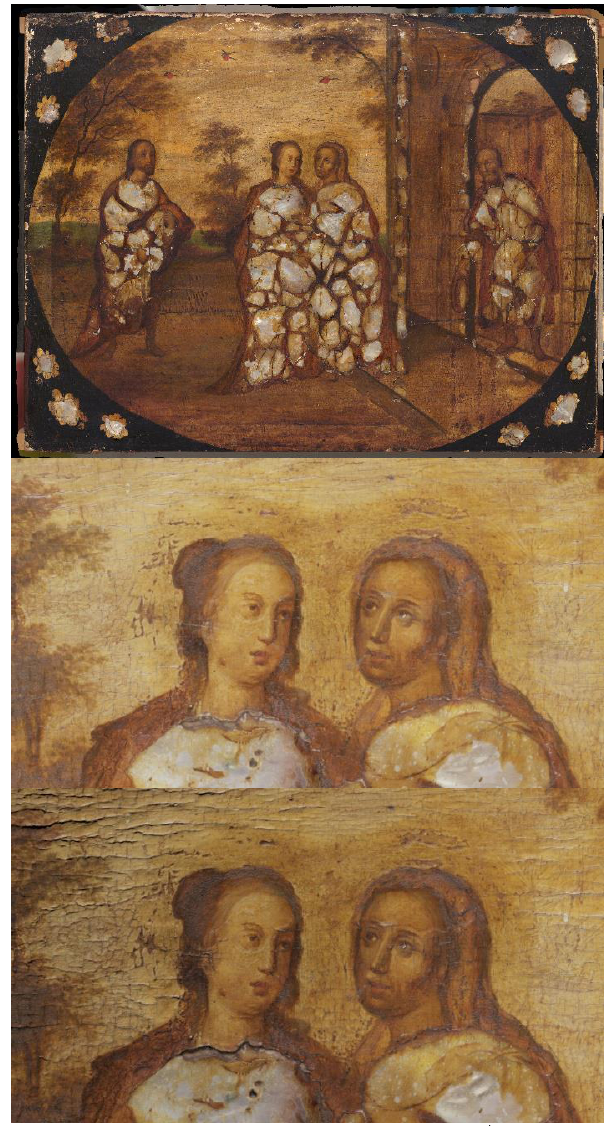
Figure 7. The final orthophoto of the unnamed 17 th -century painting (top), a rendered image of the colour orthophoto with a nadiral light (middle), a rendered image of the colour and depth with an angled light